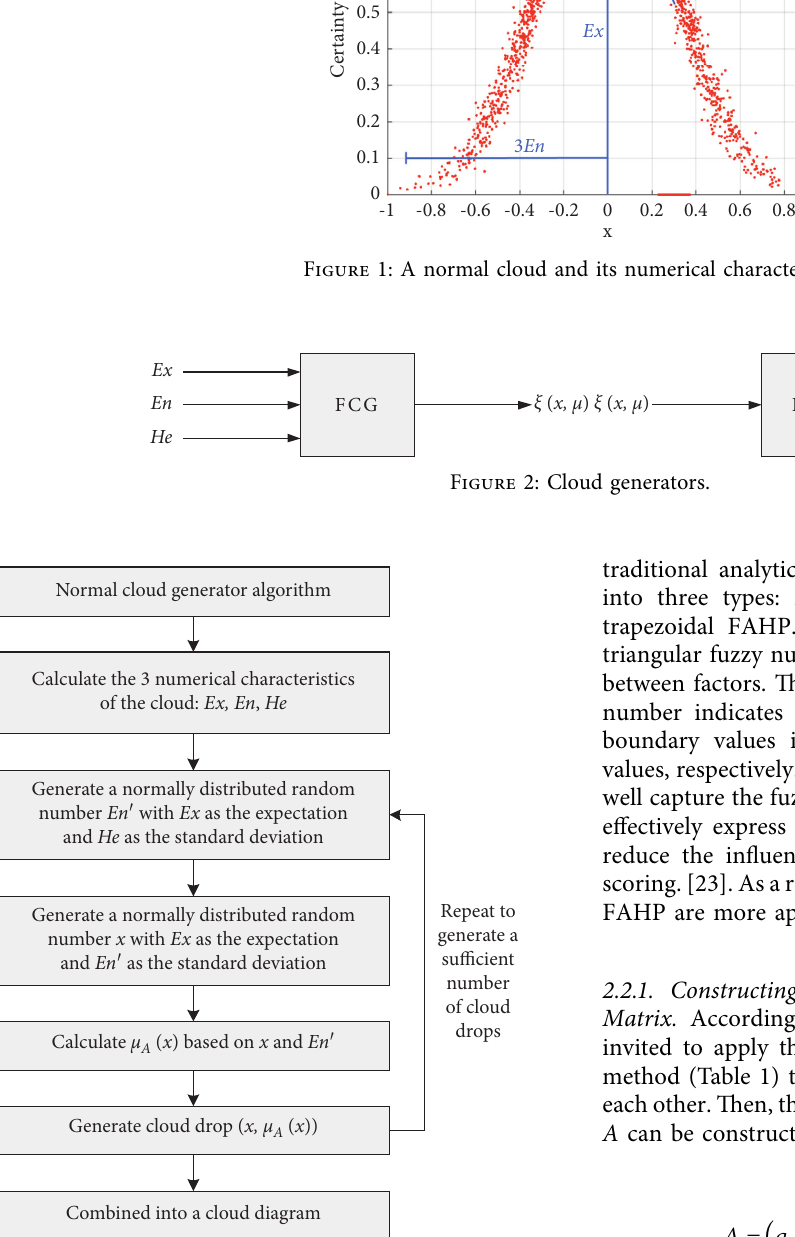
Figure 3: Steps of forward normal cloud generator